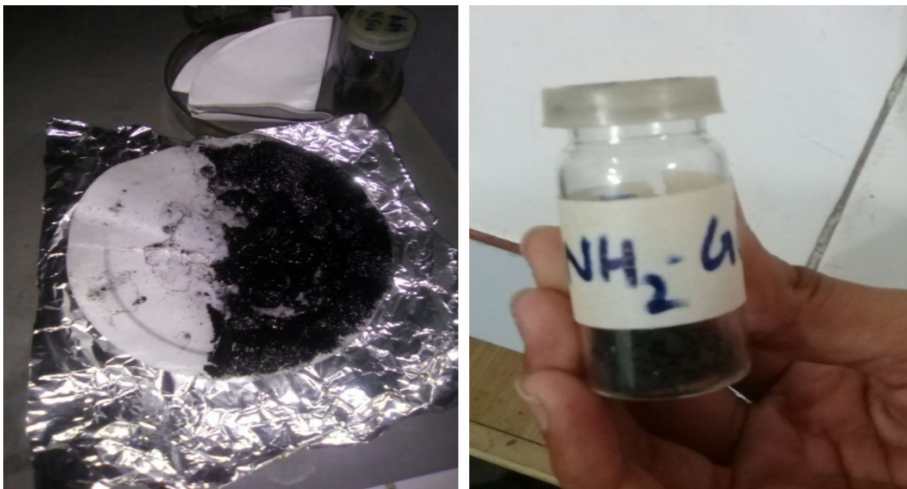
Figure 2. Synthesized aminated graphene oxide (NH 2